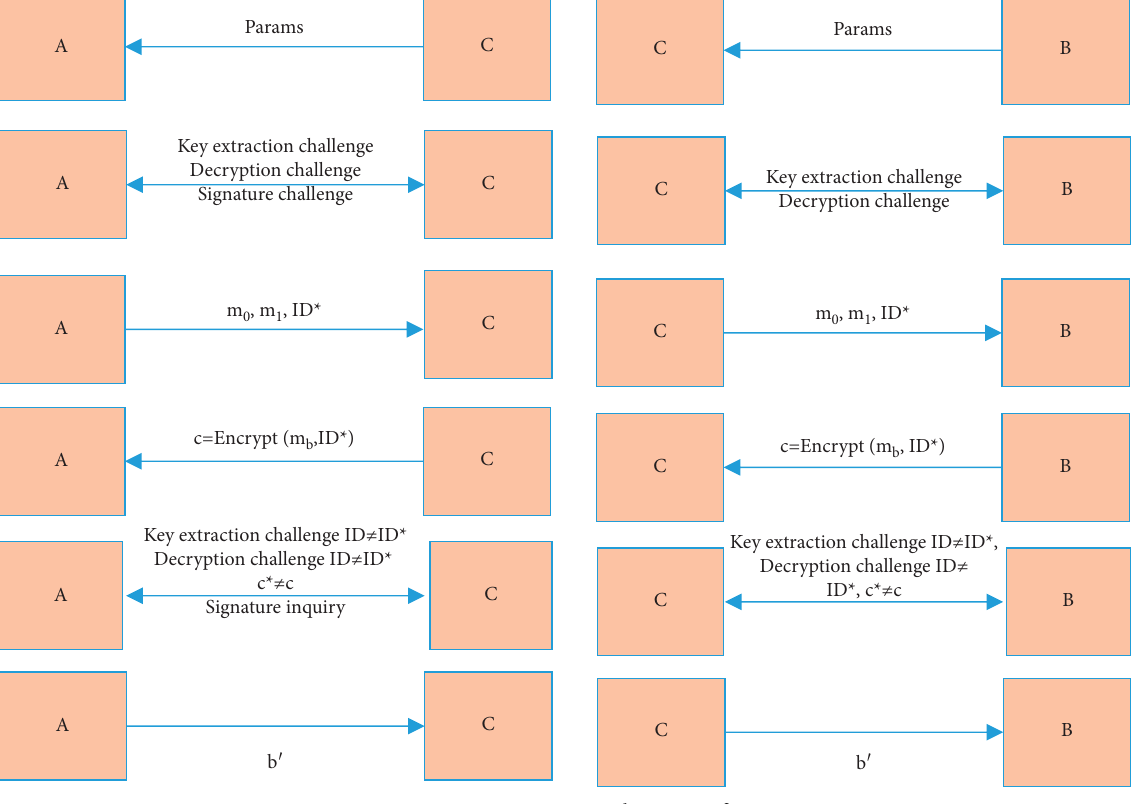
Figure 8: IBCES encryption scheme certifcation.